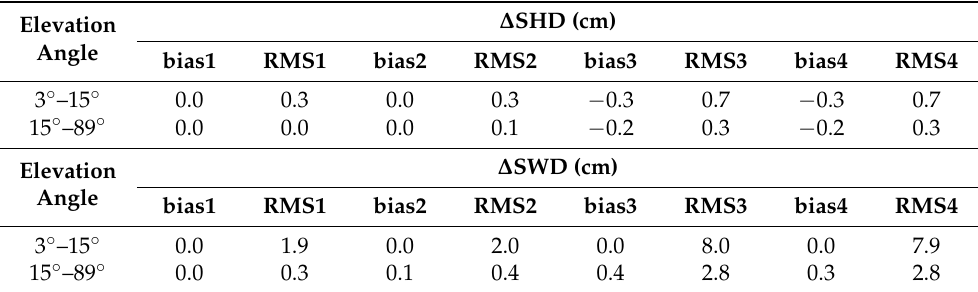
Table 5. Statistic result of TMF-derived slant delays, which are the product of the TMF and the ray-traced zenith delays. The meaning of the postfix numbers is listed in Table